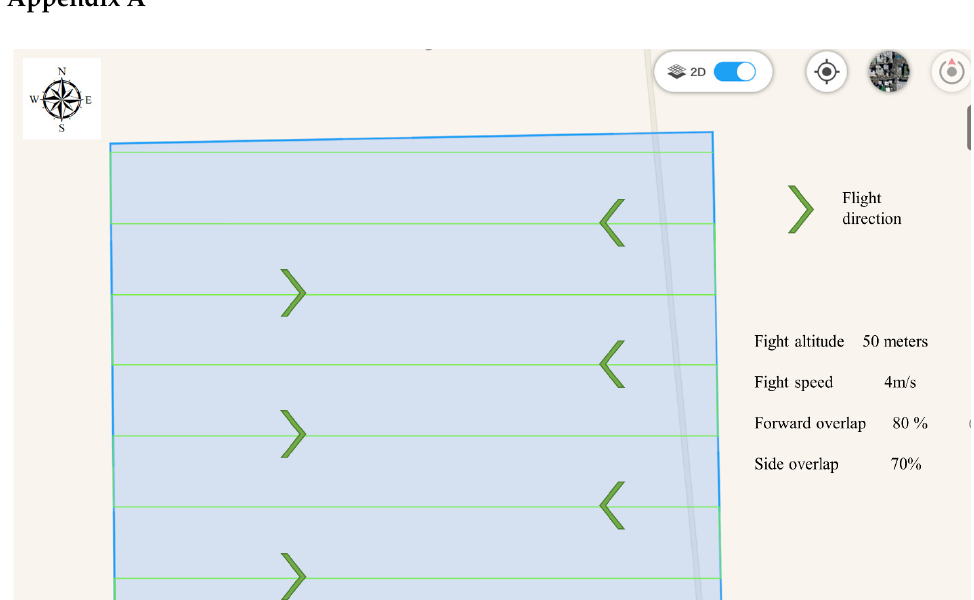
Figure A1. The detailed information of trajectory of UAV flight routes. The yellow marks are the flight directions, the light green lines are the UAV flight routes, and the whole light blue area is the coverage of UAV shooting.